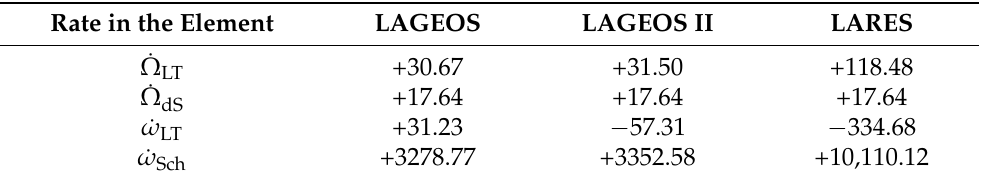
Table 2. GR precessions, in millisecond of arc per year (mas/yr), on the right ascension of the ascending node and on the argument of pericenter of LAGEOS, LAGEOS II, and LARES satellites. The LT, dS and Sch labels represent, respectively, the precessions due to the Lense-Thirring, the de Sitter and Schwarzschild